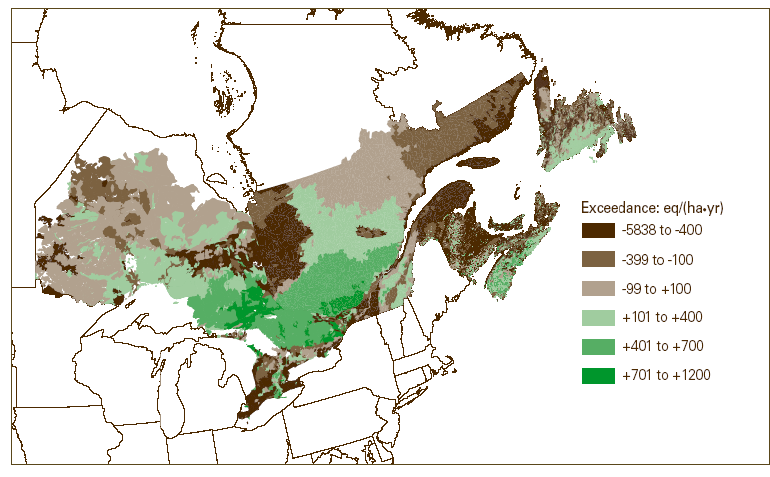
FIGURE 9. Critical load exceedance of acidifying compounds in